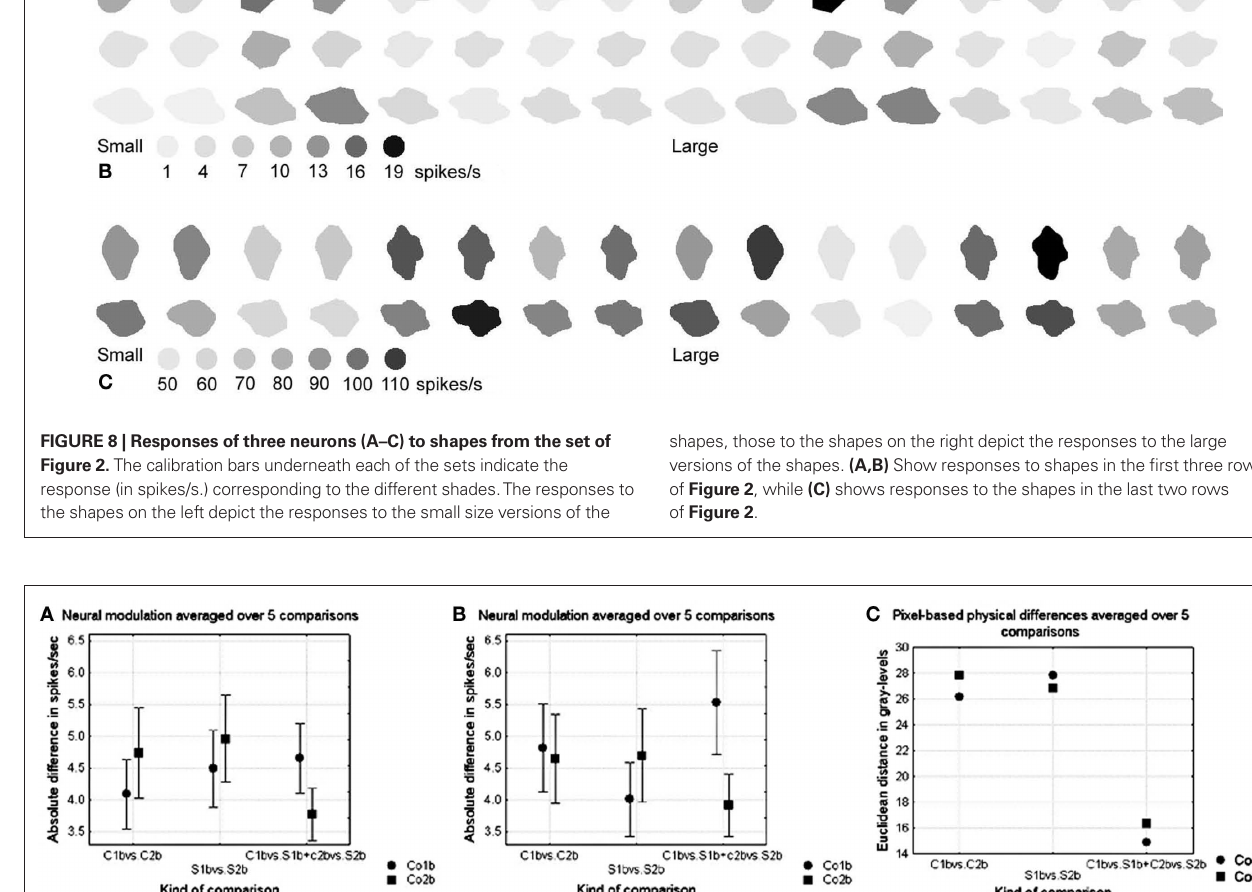
Figure 9 | (A,B) Average neural modulation for the different kinds of shape comparisons in Experiment 2. The kind of shape difference is presented on the abscissa using the column notations of Figure 2 (respectively shape differences within curved shapes, shape differences within straight shapes and curved versus straight contours) while the complexity of the shape is represented by the different symbols (circles and squares for shapes from respectively Co1b